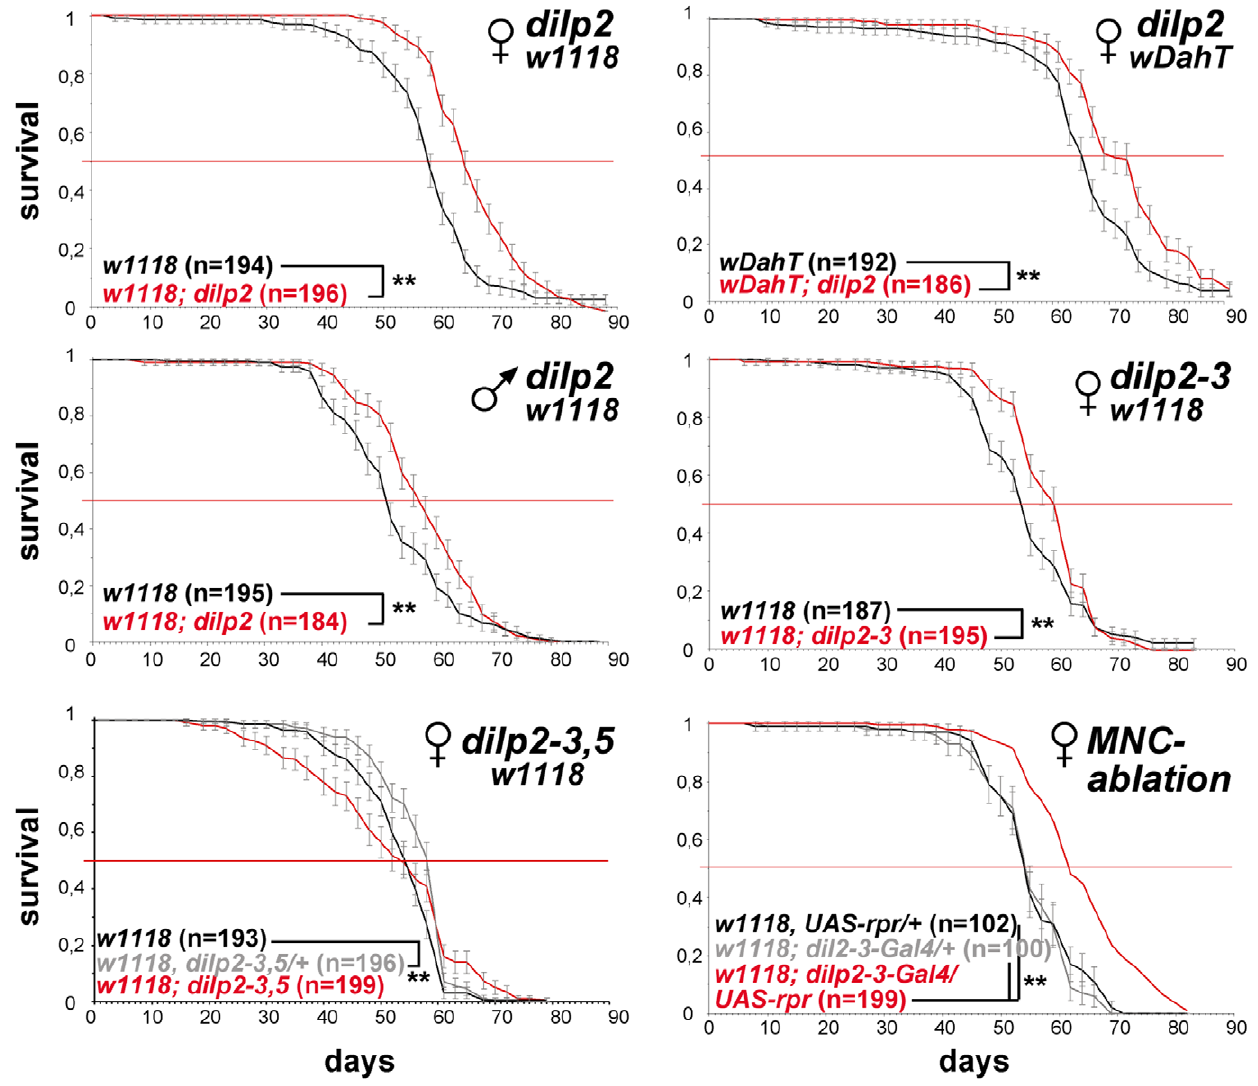
Figure 5. dilp2 mutant flies are long-lived. Survival curves of dilp mutant flies on standard food. Lack-of DILP2 extends median lifespan in two independent genetic backgrounds ( w 1118 and w DahT ) and in both sexes. Combined knock out of DILP2 and 3 results in increased lifespan. In contrast to MNC-ablated flies, homozygous w 1118 ; dilp2–3,5 mutants do not show increased median lifespan. However, median lifespan is slightly increased in dilp2–3,5 heterozygous flies. ** p , 0.001, log-rank